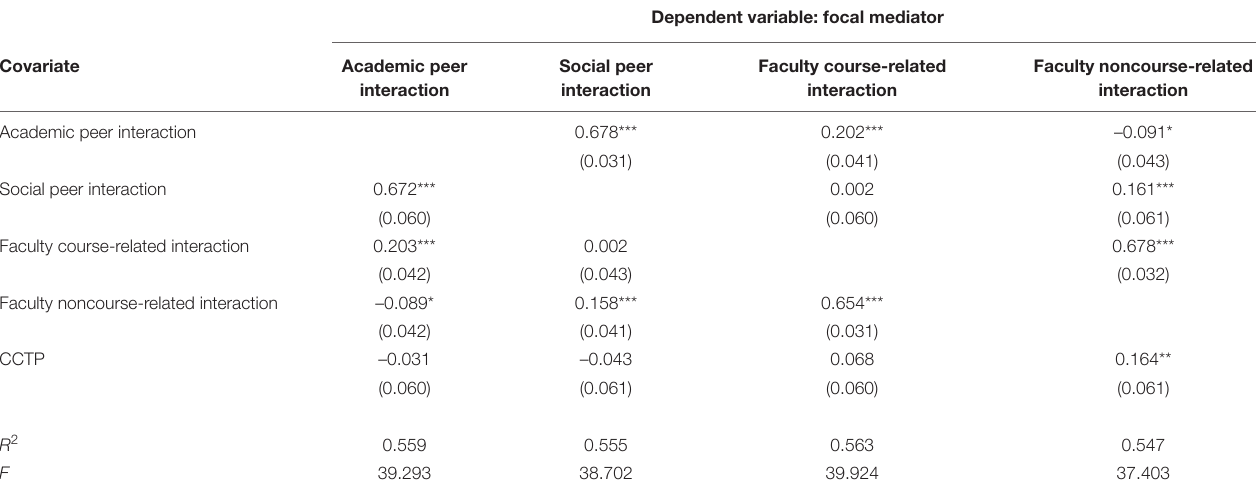
TABLE 6 | Associations of each interaction mediator with other interaction